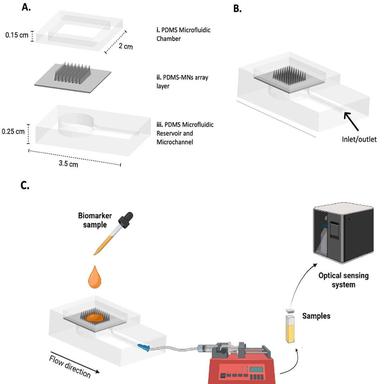
PMN-fluidic prototype device. A. Schematic illustration of the device prototype layers: i. PDMS Microfluidic chamber, ii. PDMS-MNs array layer, iii. PDMS microfluidic chamber and microchannel. B. Schematic representation of the bonded layers. C. Schematic illustration of the setup used for the collection and detection of the albumin concentration using the MN-fluidic prototype.